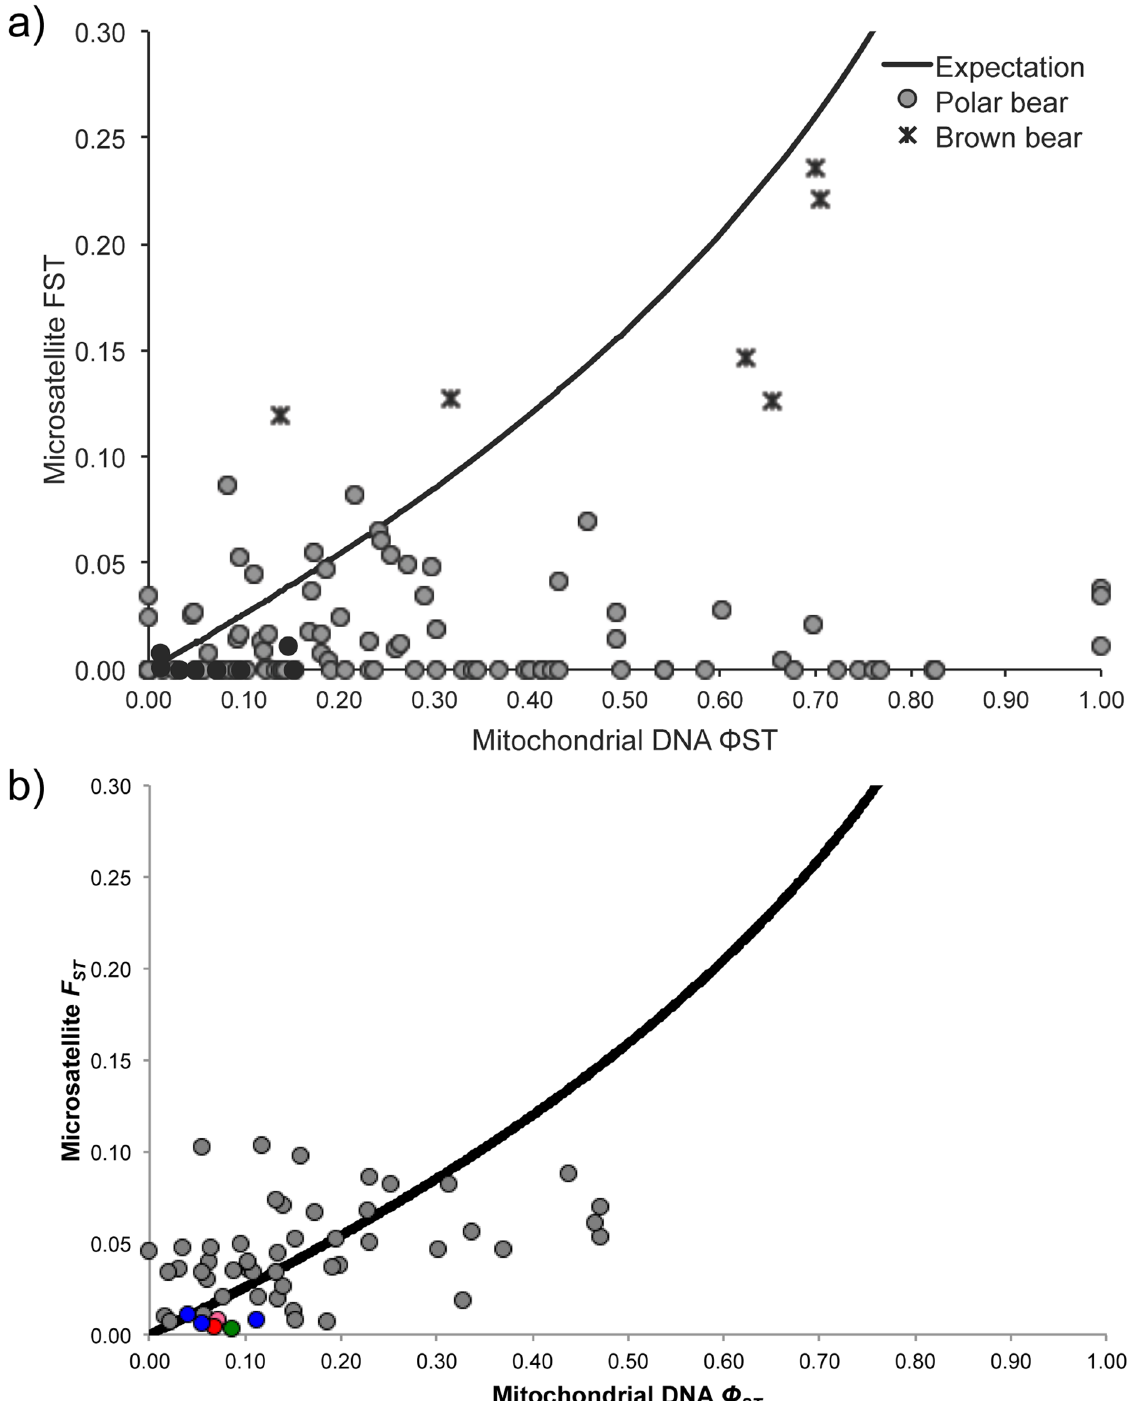
Fig 7. Comparisons of pairwise F ST values for nuclear microsatellites with Φ ST values from mitochondrial DNA; the line indicates the expectation of F ST ð nu Þ ¼ 1 (cid:3) e 0 : 25 (cid:4) ln ½ 1 (cid:3) F ST ð mt Þ(cid:5) under isolation as given in [56]. (a) S4 Fig from Peacock et al ., 2015 [20], reproduced here under the terms of its